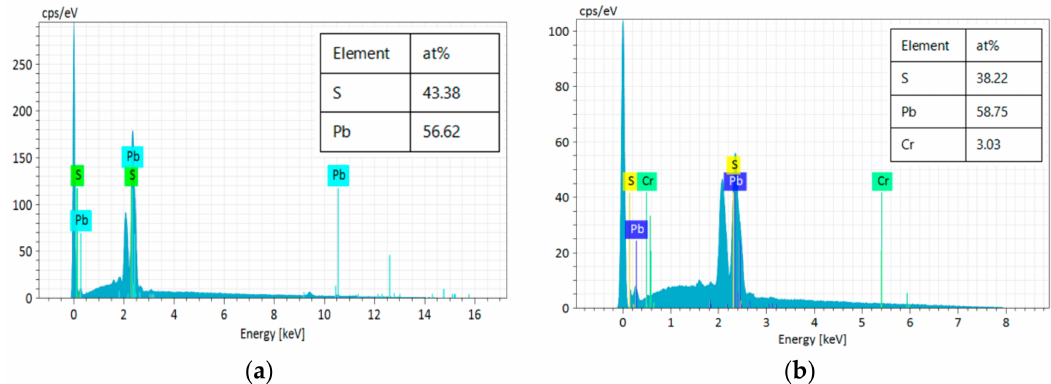
Figure 3. EDS of pristine PbS films: ( a ) 0 at.% Cr-doped PbS film, and ( b ) 5 at.% Cr-doped PbS